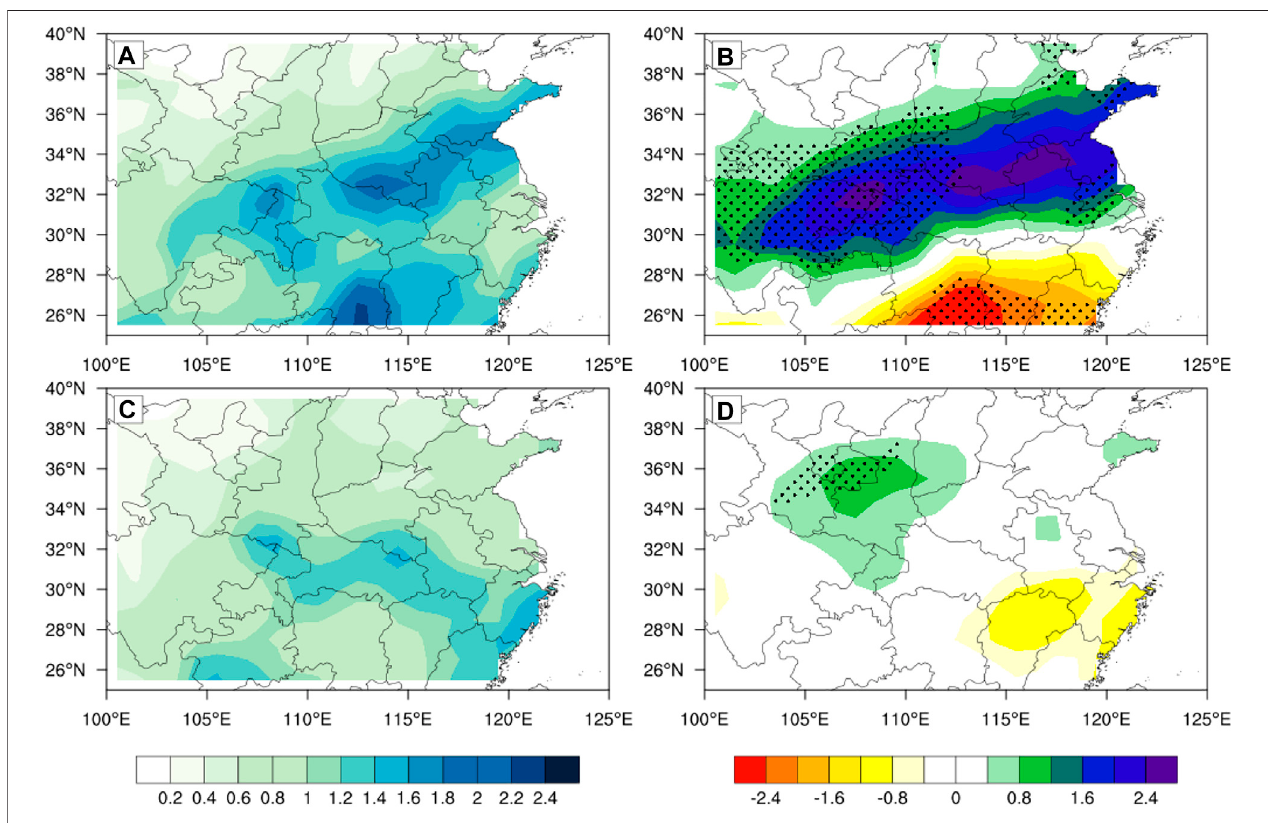
FIGURE 2 | Spatial patterns of summer rainfall differences between the composites of positive and negative years (unit: mmd − 1 ; (B) for P1 and (D) for P2; dotted areas indicate the values are signi fi cant at/above the 95% con fi dence level by Student ’ s t test.) and variance of summer rainfall [unit: mmd − 1 ; (A) for P1 and (C) for P2].